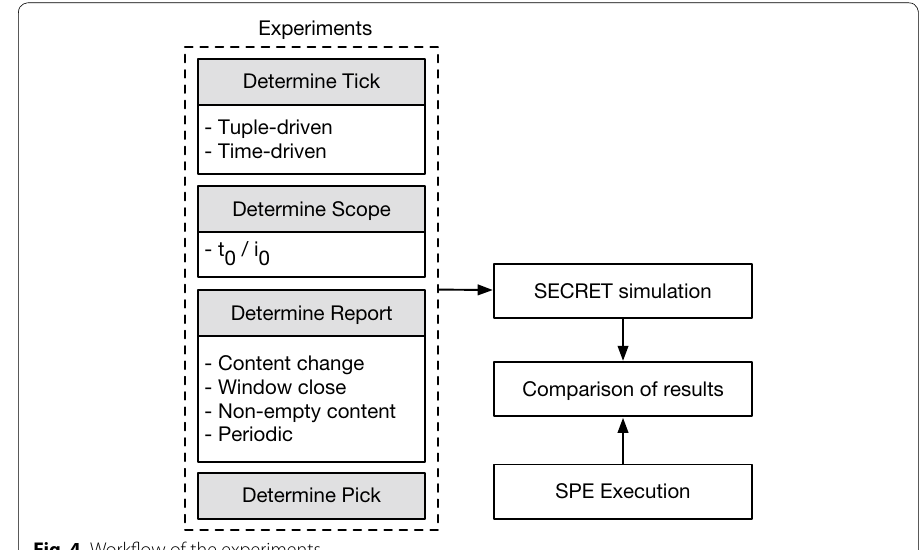
Fig. 4 Workflow of the